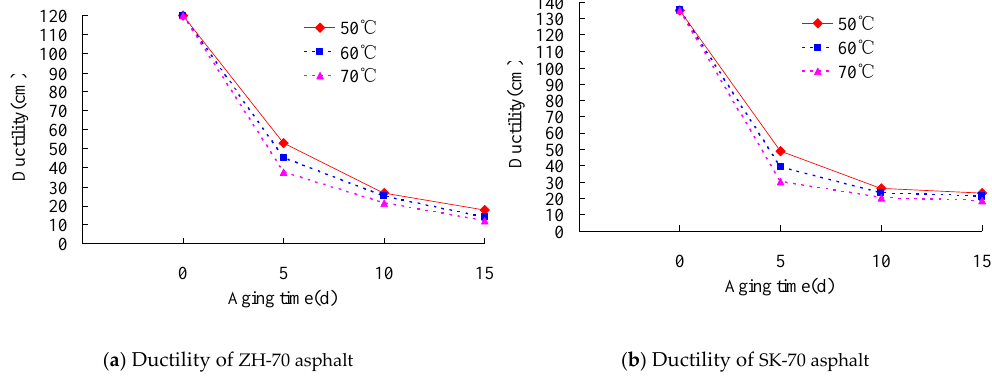
Figure 5. Relationship between ductility and aging times for different temperatures.